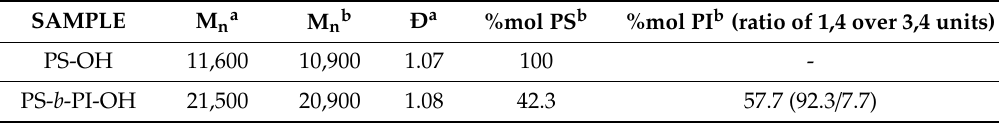
1 H-NMR spectrum of sample PS-OH. Figure 1. 1 H ‐ NMR spectrum of sample PS ‐ OH. Figure 1. Table 1. Molecular characteristics of the end-functionalized